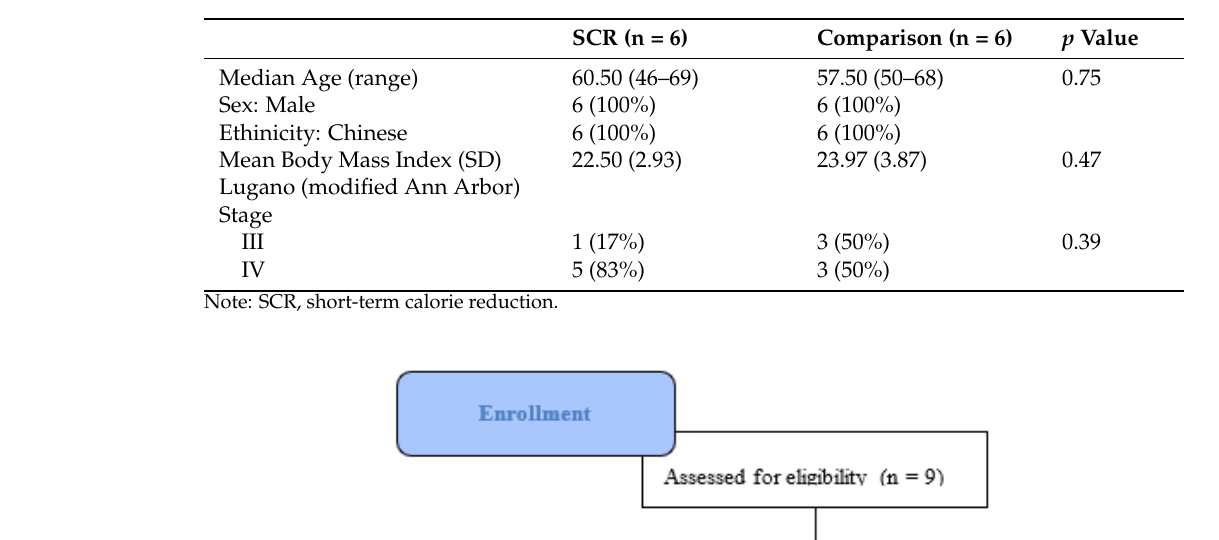
Table 1. Patient characteristics.